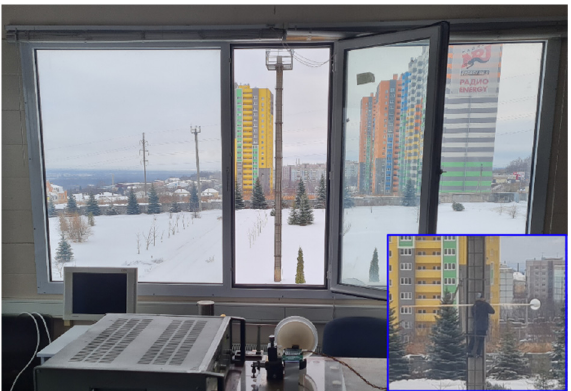
Figure 6. An overall photograph of the scene at an initial condition of the outdoor experiment: a pole without the spherical-cap reflector. Inset: a close-up photograph of reflecting objects; a spherical-cap reflector is being attached to the pole.